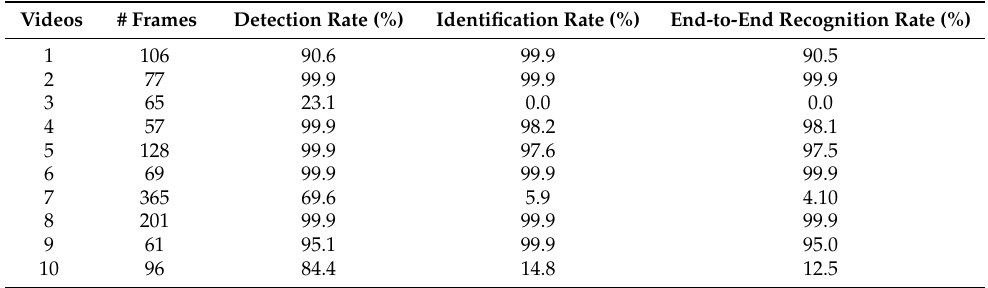
Table 16. Identification rate with our proposed system evaluated on the YTF dataset. The YOLO-Face model and the FaceNet+SVM model are adopted for face detection and face recognition, respectively. Videos # Frames Detection Rate (%)